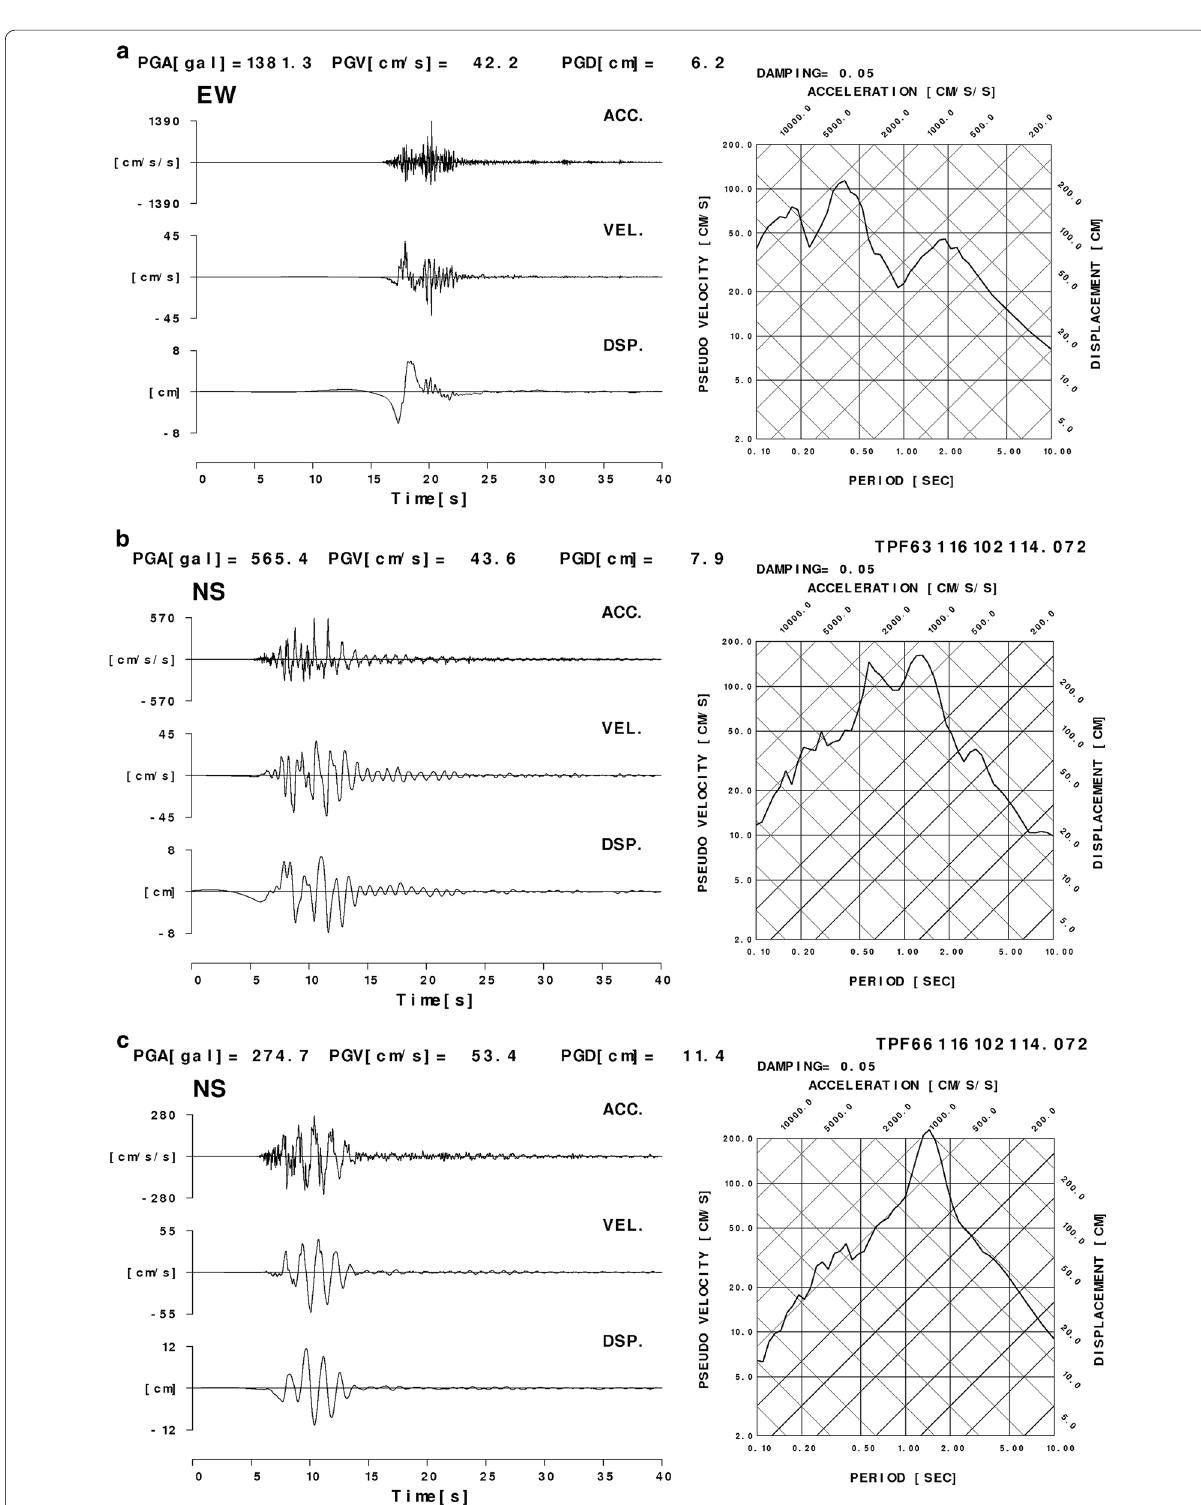
Fig. 2 Observed ground motions at the a Kurayoshi City Office, b Togo Site (Ryuto, Yurihama Town), and c Hojo Site (Hashita, Hokuei Town), with a common JMA seismic intensity of 5.8 (6 lower). The acceleration, integrated velocity, and displacement traces of the larger horizontal component observed at each site are shown in the left-hand panels ; the pseudo-velocity response spectrum with 5% damping is plotted with absolute accelera- tion and pseudo-displacement response axes in the right-hand